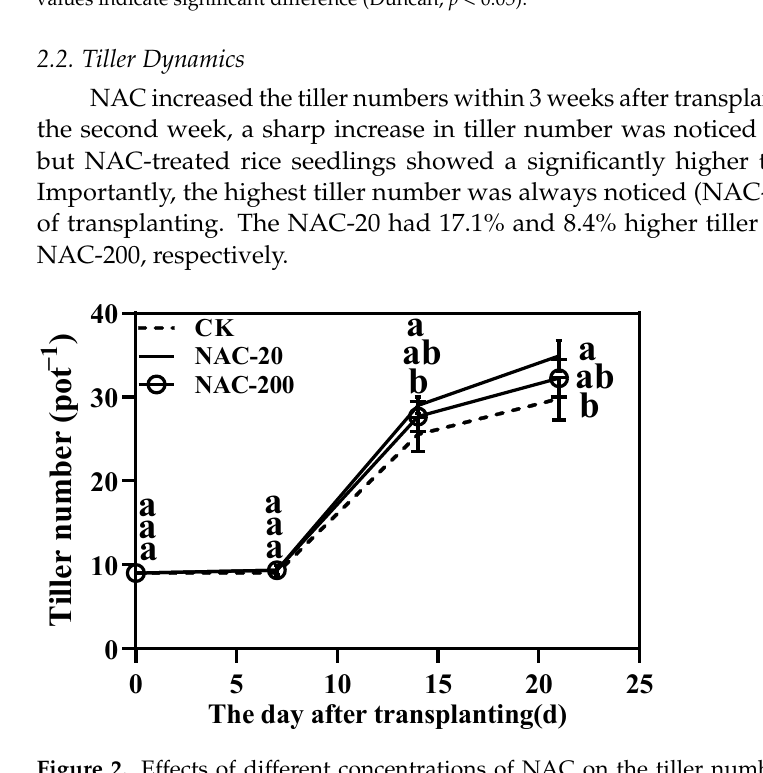
following average values indicate significant difference (Duncan, p < 0.05).